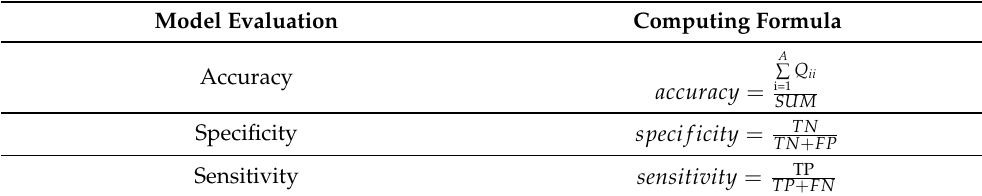
Table 3. Calculation formula for model